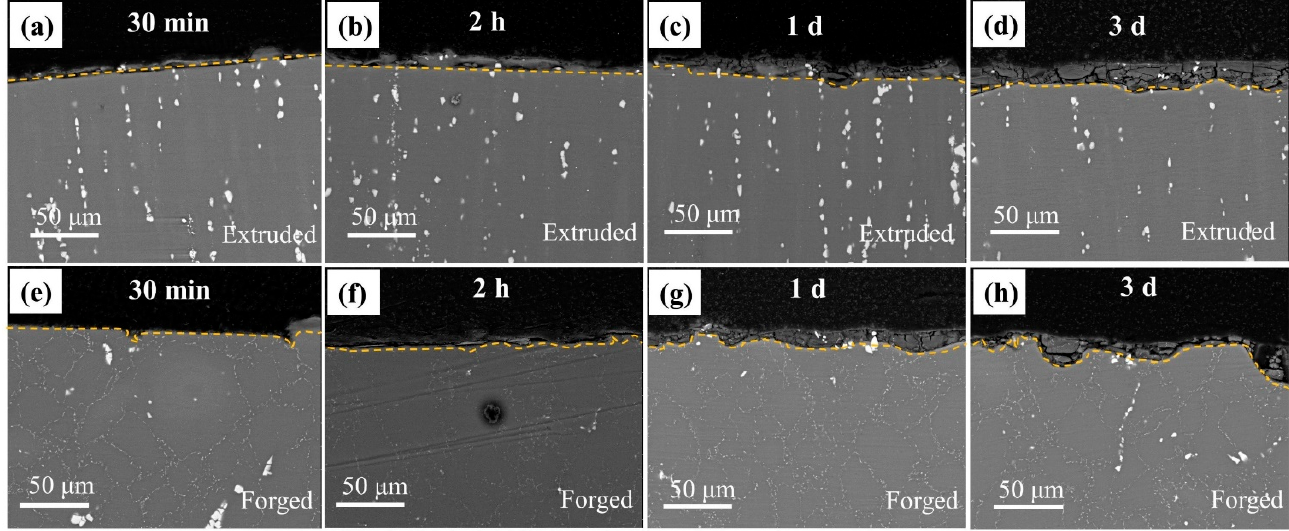
Figure 7. Cross–sectional morphologies of the ( a – d ) extruded and ( e – h ) forged WE43 alloys after immersion in 0.6 M NaCl solution for ( a , e ) 30 min, ( b , f ) 2 h, ( c , g ) 1 day, and ( d , h ) 3 days.